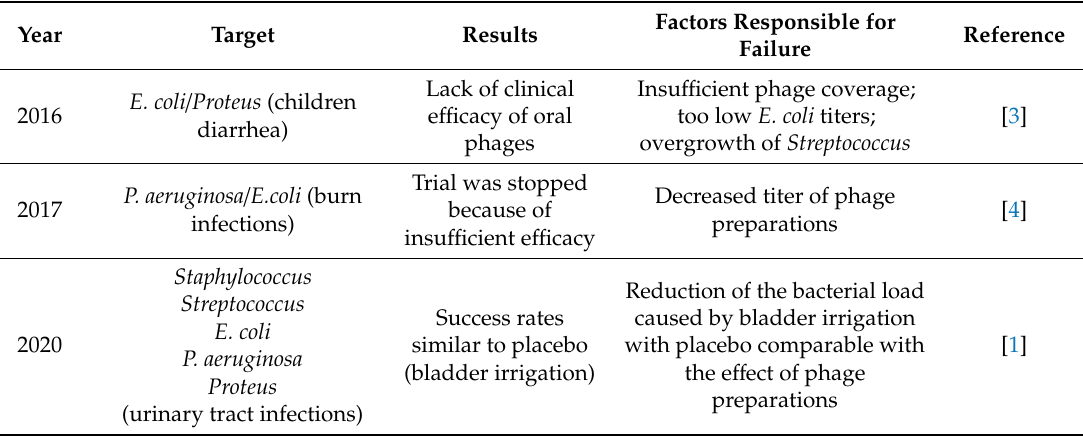
Table 1. Summary of most important phage therapy